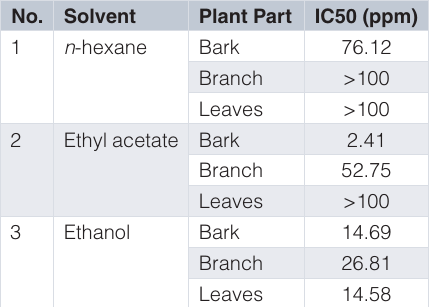
Table 2. Half-maximal inhibitory concentration (IC50) values of L. angulata extracts on DPPH free